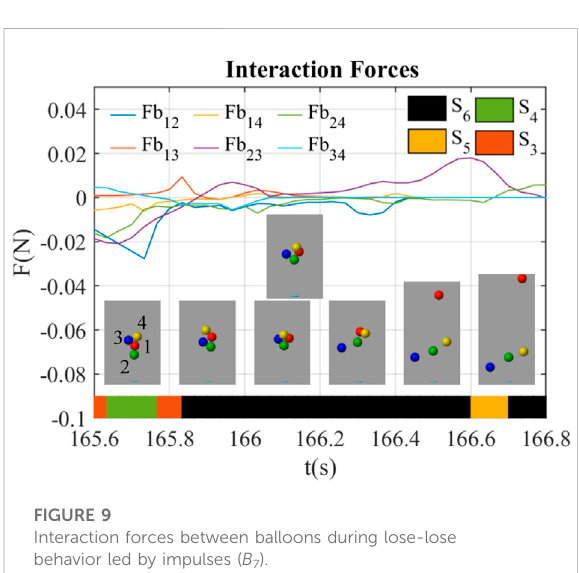
FIGURE 9 Interaction forces between balloons during lose-lose behavior led by impulses ( B 7